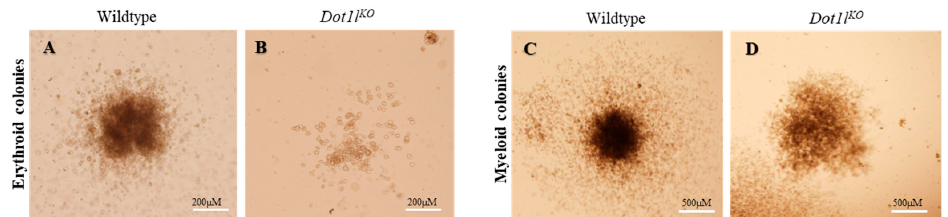
Figure 3. Equal numbers of wild-type and Dot1l KO E10.5 yolk sac cells were cultured in methylcellulose medium containing cytokines that promoted definitive erythroid and myeloid lineage differentiation. While Dot1l KO progenitors formed significantly smaller sized erythroid (BFU-E) colonies ( A , B ), the wild-type and Dot1l KO myeloid colonies (CFU-GM) were similar in size ( C , D ).